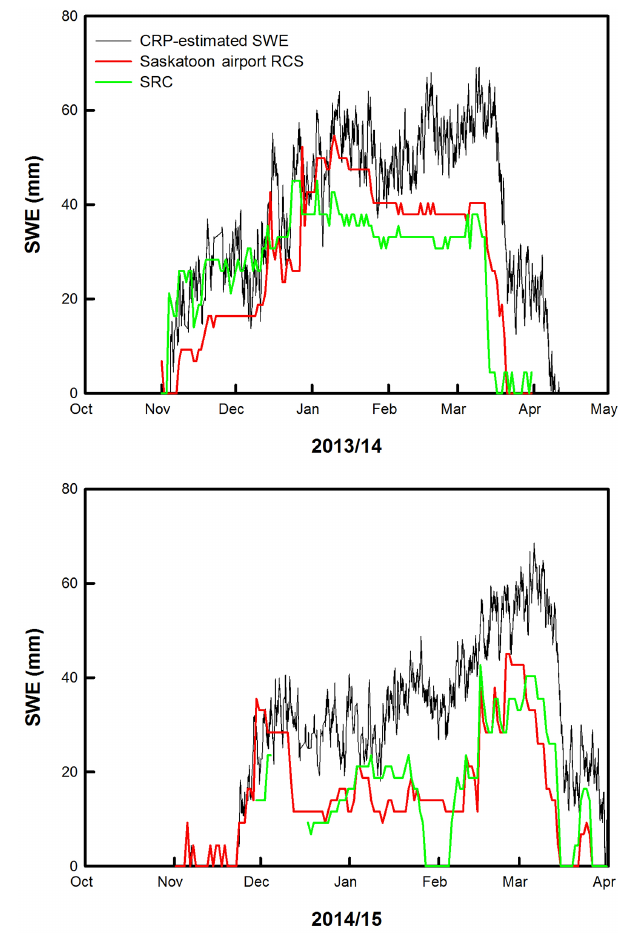
Figure 7. CRP-estimated SWE and SWE estimated from snow depth for 2013/2014 (top) and 2014/2015